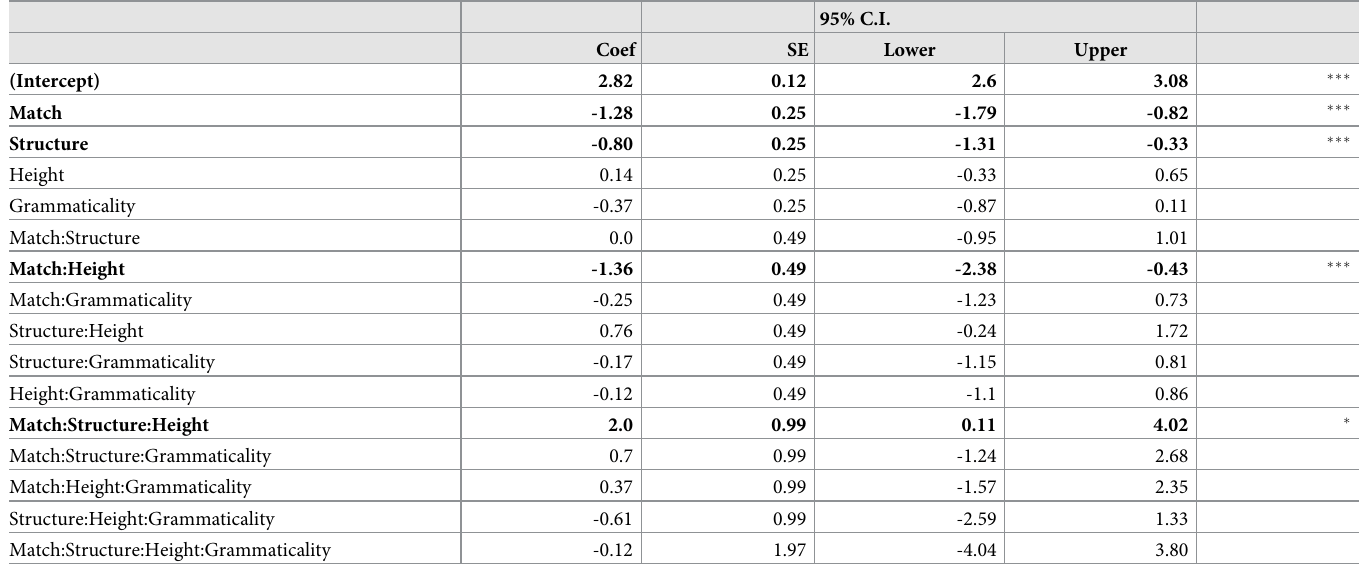
Table 3. Logistic regression on grammaticality judgment accuracy in Experiment